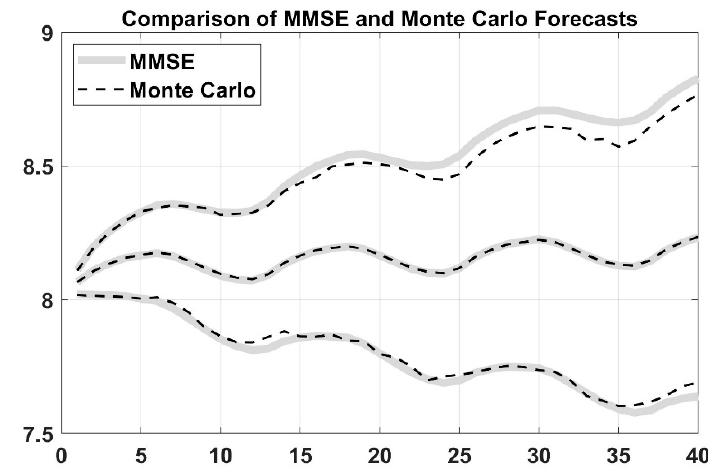
Figure 28. Per week forecasting validation using MC.